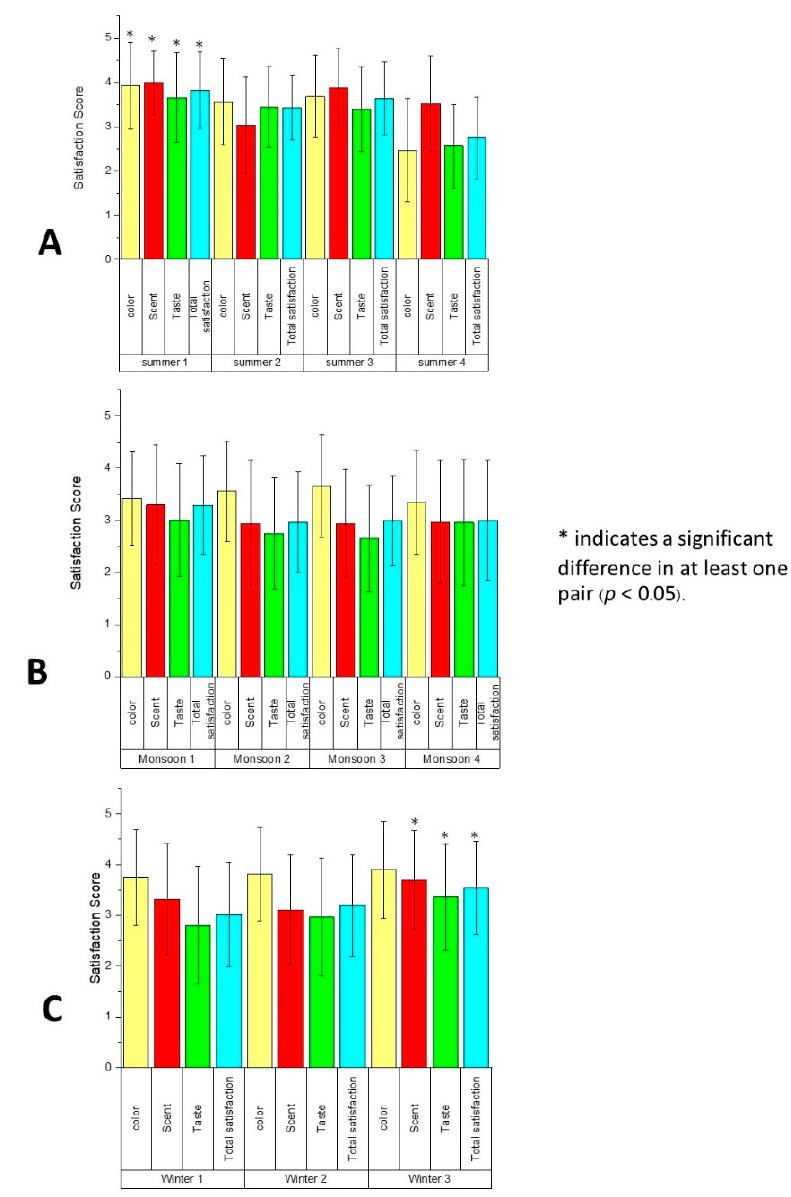
Figure 3 . Satisfaction tests of Thai identity herbal tea recipes : ( A ) Summer tea recipes, ( B ) monsoon Figure 3. Satisfaction tests of Thai identity herbal tea recipes: ( A ) Summer tea recipes, ( B ) monsoon tea recipes, ( C ) winter tea recipes. Asterisks indicate a significant di ff erence in at least one pair ( p < tea recipes, ( C ) winter tea recipes . Asterisks indicate a significant difference in at least one pair ( p < 0 . 05) .